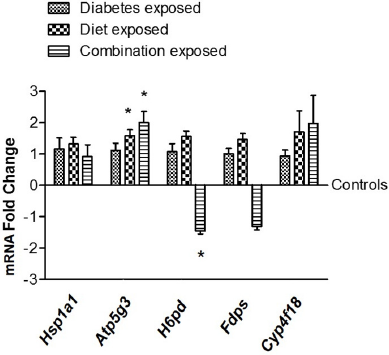
Figure 7. Gene expression validation of selected candidate genes with enriched H3K4me3 marks (compared to controls) on their promoters. Beta-2-microglobulin was used as a reference gene for normalizing gene expression levels. n = 4, * p < 0.05.